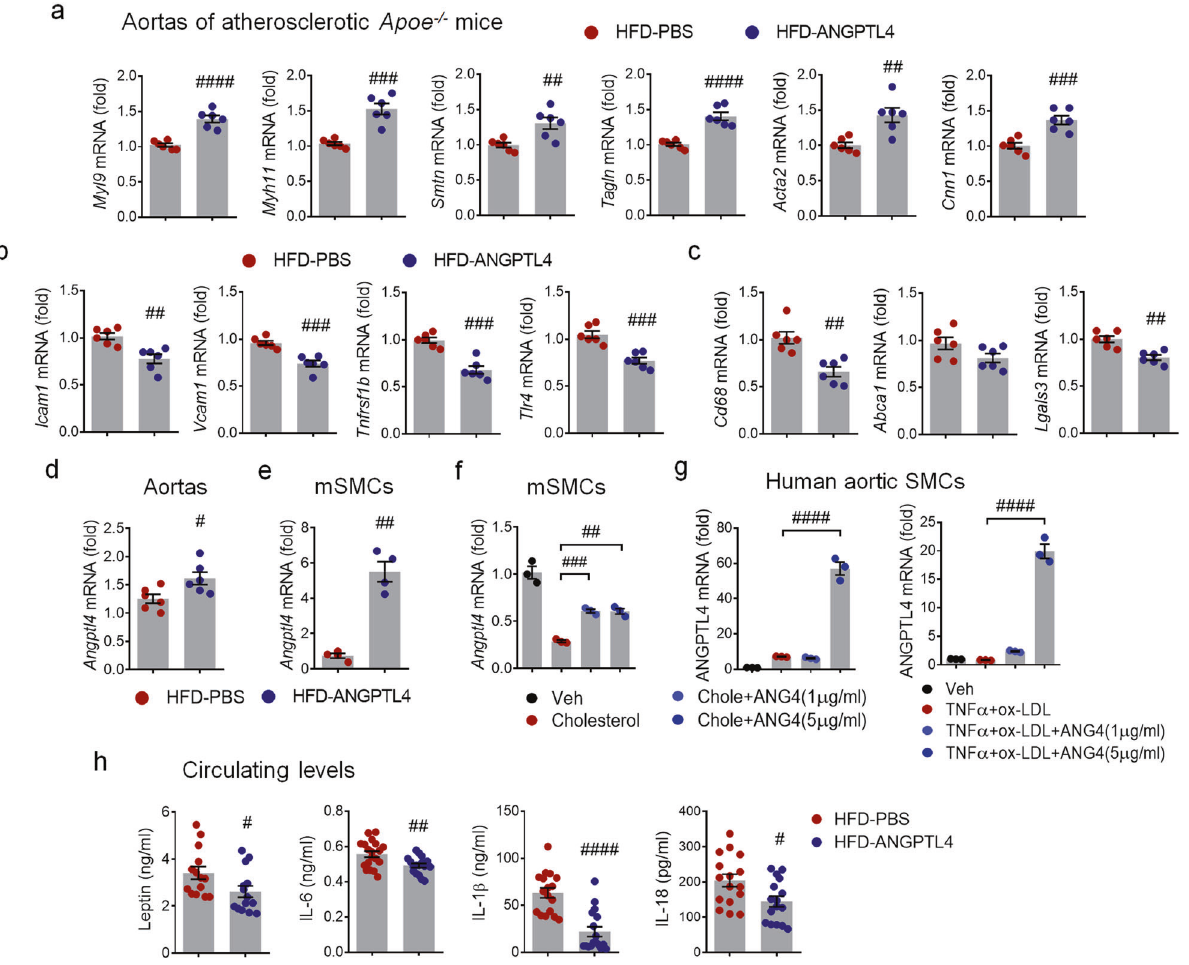
Fig. 3 The expression patterns of atherogenic mediators from the aortas and plasma of Apoe − / − mice. Relative expression of genes related to contractility ( a ), proin fl ammation ( b ), and macrophage markers ( c ) in aortas isolated from the PBS and ANGPTL4 groups. Apoe − / − mice fed a high-fat diet (HFD) were injected with PBS or ANGPTL4 twice a week for 8 weeks (2 μ g, i.p .). ANGPTL4 expression in aortas ( d ) and aortic SMCs ( e , f ) of Apoe − / − mice and human aortic SMCs ( g ). Aortic SMCs were stimulated with cholesterol (10 μ g/ml) or TNF α (100 ng/ml) and oxLDL (10 μ g/ml) with or without ANGPTL4. h Circulating leptin, IL-6, IL-1 β , and IL-18 were quanti fi ed in the PBS and ANGPTL4 groups. Data were presented as the mean ± SEM. # p < 0.05, ## p < 0.01, ### p < 0.001, #### p < 0.0001 (by Student ’ s t -test or one-way ANOVA with Bonferroni ’ s multiple-comparisons